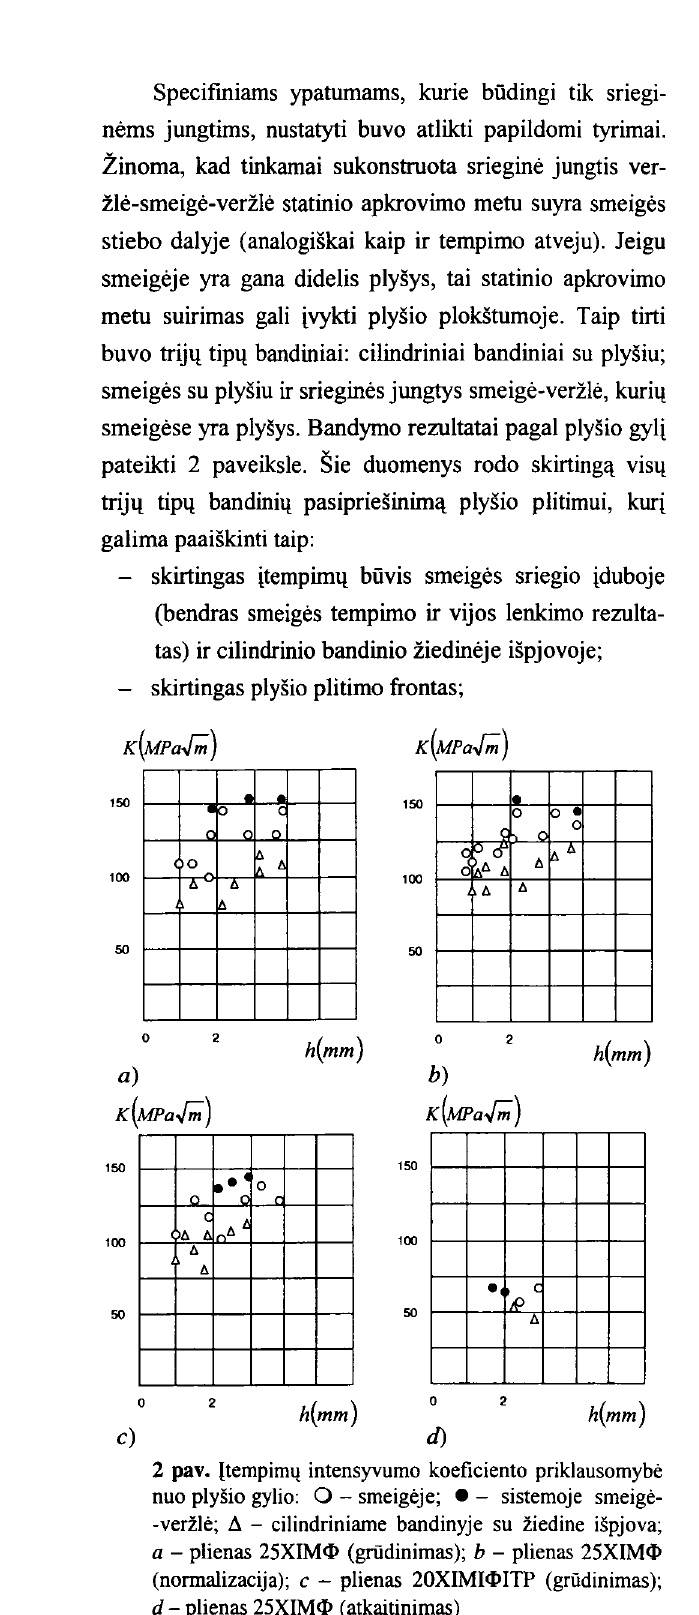
Fig 2. Dependence of stress intensity ratio on the crack depth: 0 - in the stud; • - in the system 'stud-nut'; 11 - in the cylindrical specimen with a ring notch; a -